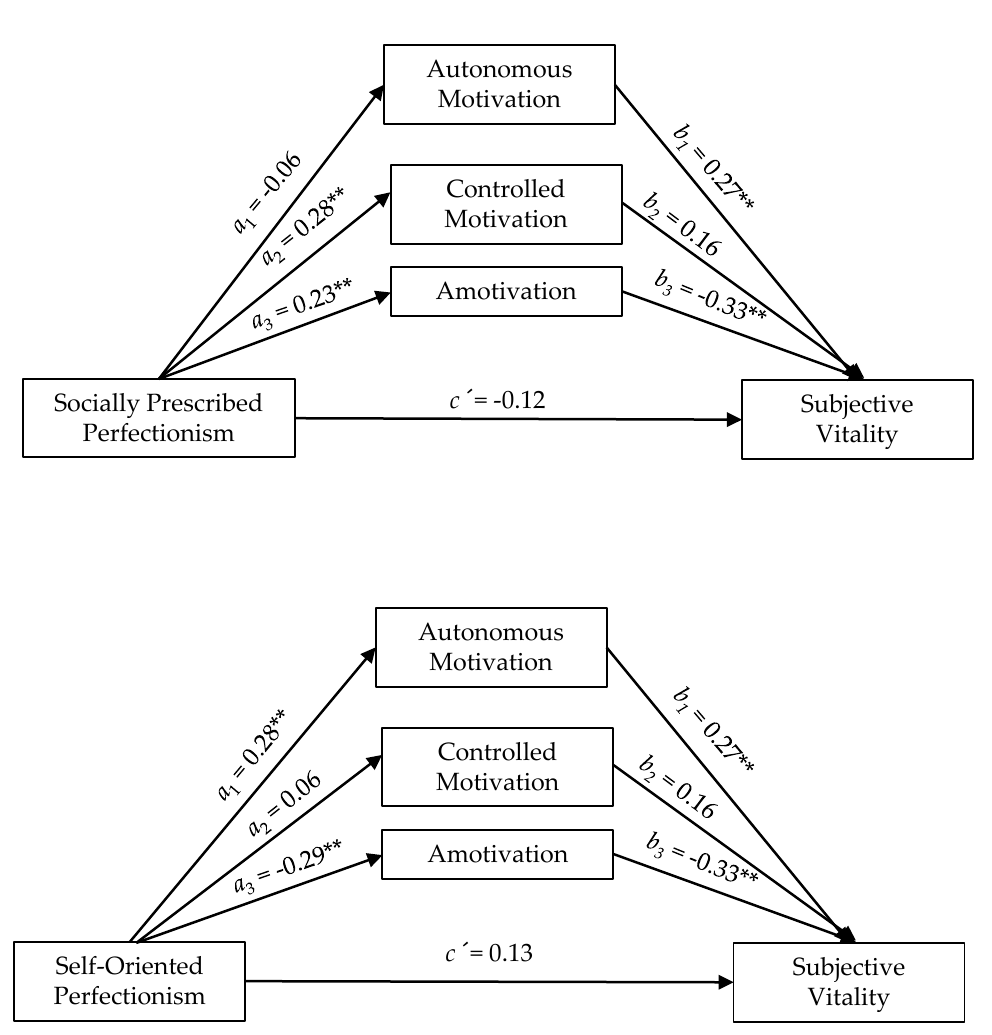
Figure 2. Graphic representation of forms of motivation as mediators between socially prescribed perfectionism and self-oriented perfectionism with subjective vitality. ** p < 0.01; * p < 0.05.